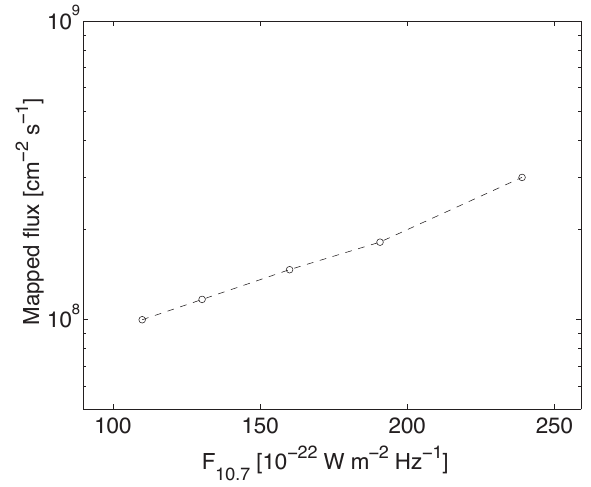
Fig. 9. Solar radiation dependence. The mapped ionospheric flux as a function of F 10 . 7